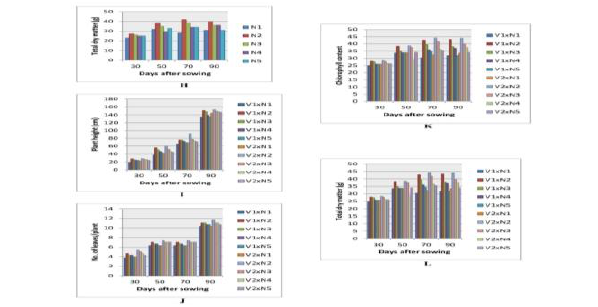
Figure 4: Illustration: H: Effect of different sources of nitrogen on total dry matter (g) of baby corn; I: Interaction effect of varieties and different sources of nitrogen on plant height (cm) of baby corn; J: Interaction effect of varieties and different sources of nitrogen on No. of leaves/plant of baby corn; K: Interaction effect of varieties and different sources of nitrogen on chlorophyll content (spad value) of baby corn; L: Interaction effect of varieties and different sources of nitrogen on total dry matter (g)